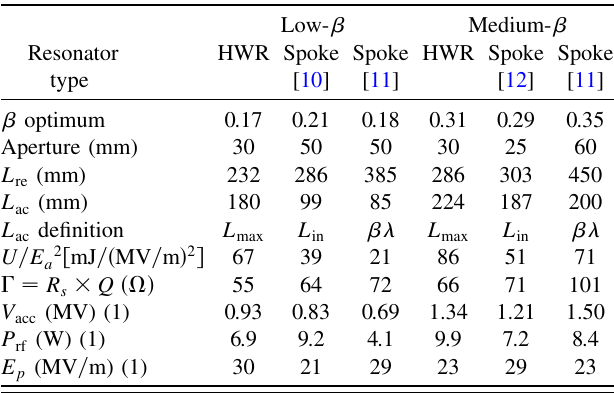
TABLE II. Main rf parameters and dimensions in typical 352 MHz coaxial HWR and 2-gap Spoke resonators with similar optimum (cid:1) , calculated from data available in literature. To compare different geometries and L have been normalized to the following specified and E p